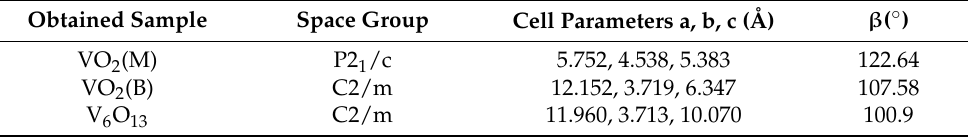
Table 2. The crystallography data of the obtained phases with different precursor concentrations. Obtained